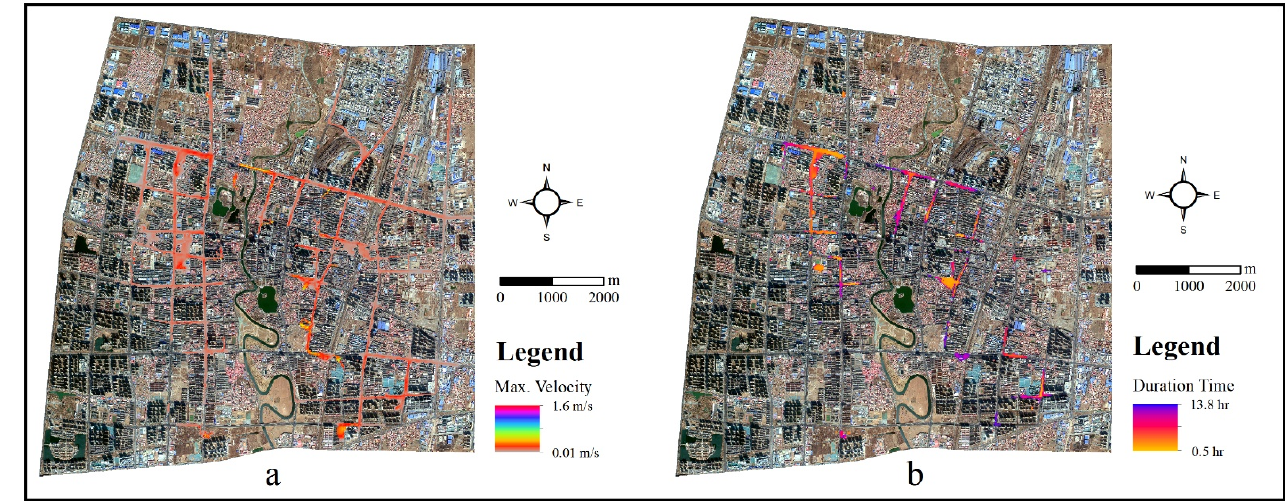
Figure 8. ( a ) Spatial distribution of the maximum velocity under a 3-year return period; ( b ) spatial distribution of the inundation depth above 40 cm under a 3-year return period.